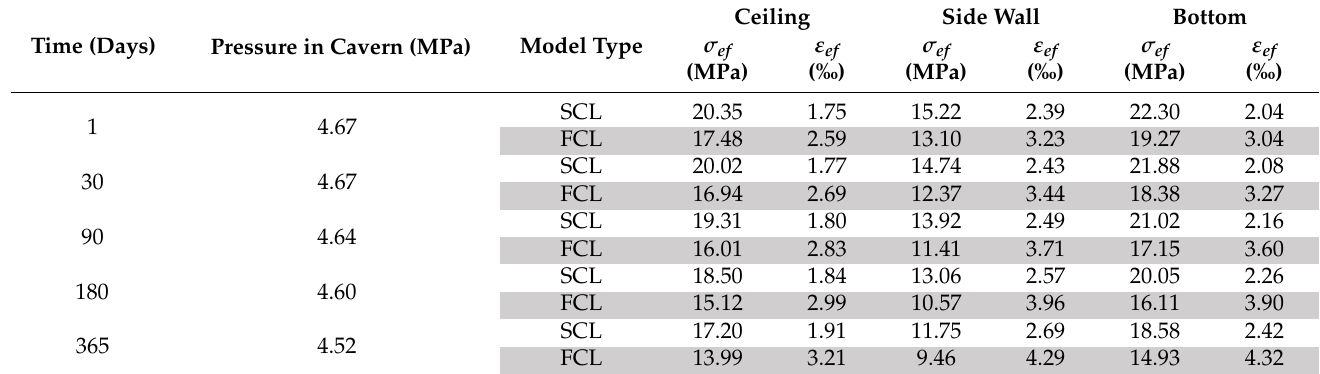
Table 7. Strength criteria for the two salt-creep models. Status at the end of a given emptying cycle (after 6 h of cavern rest under minimum pressure).